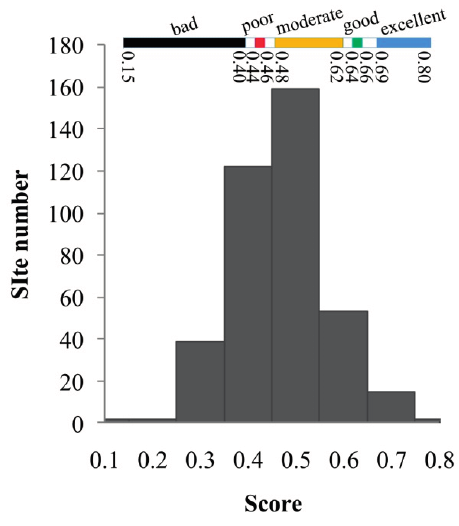
Figure 2. Distribution of assessed score values.